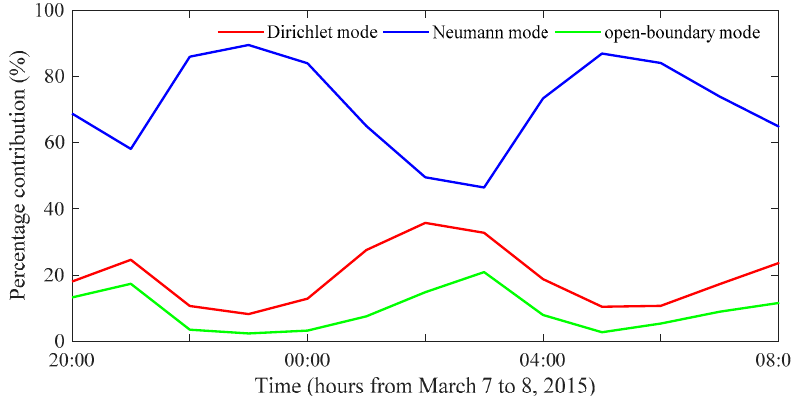
Figure 4. Time plots of the percentage contribution from the Dirichlet mode (red line), the Neumann mode (blue line), and the open-boundary mode (green line) to the total kinetic energy.